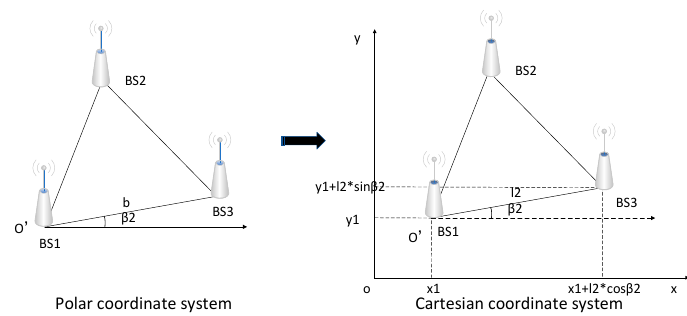
Figure 7. Typical deployment scenarios of base stations in field.